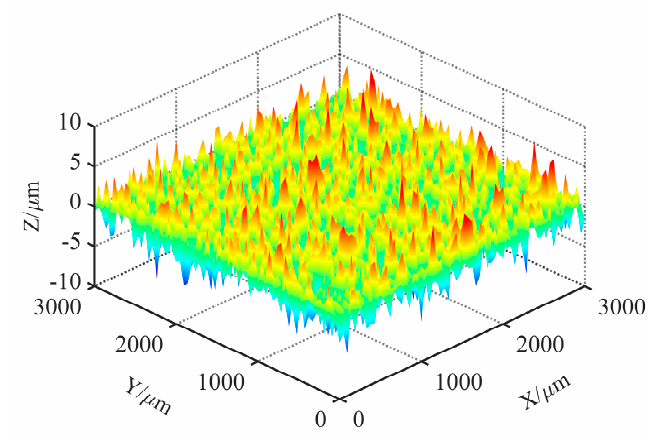
Figure 8. Simulation topography of grinding wheel.